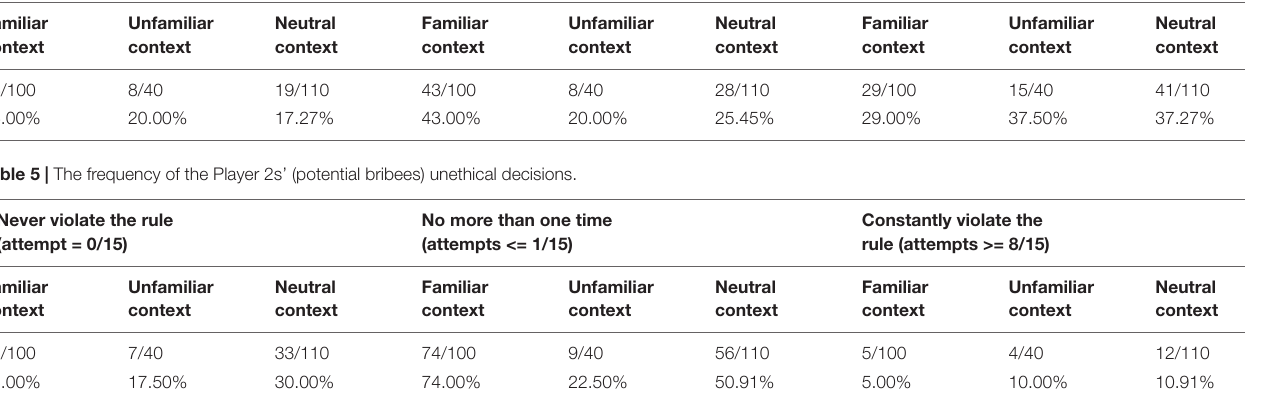
Table 4 | The frequency of the player 1s’ (potential bribers) bribing attempts. Never offer bribe (attempt=0/15)